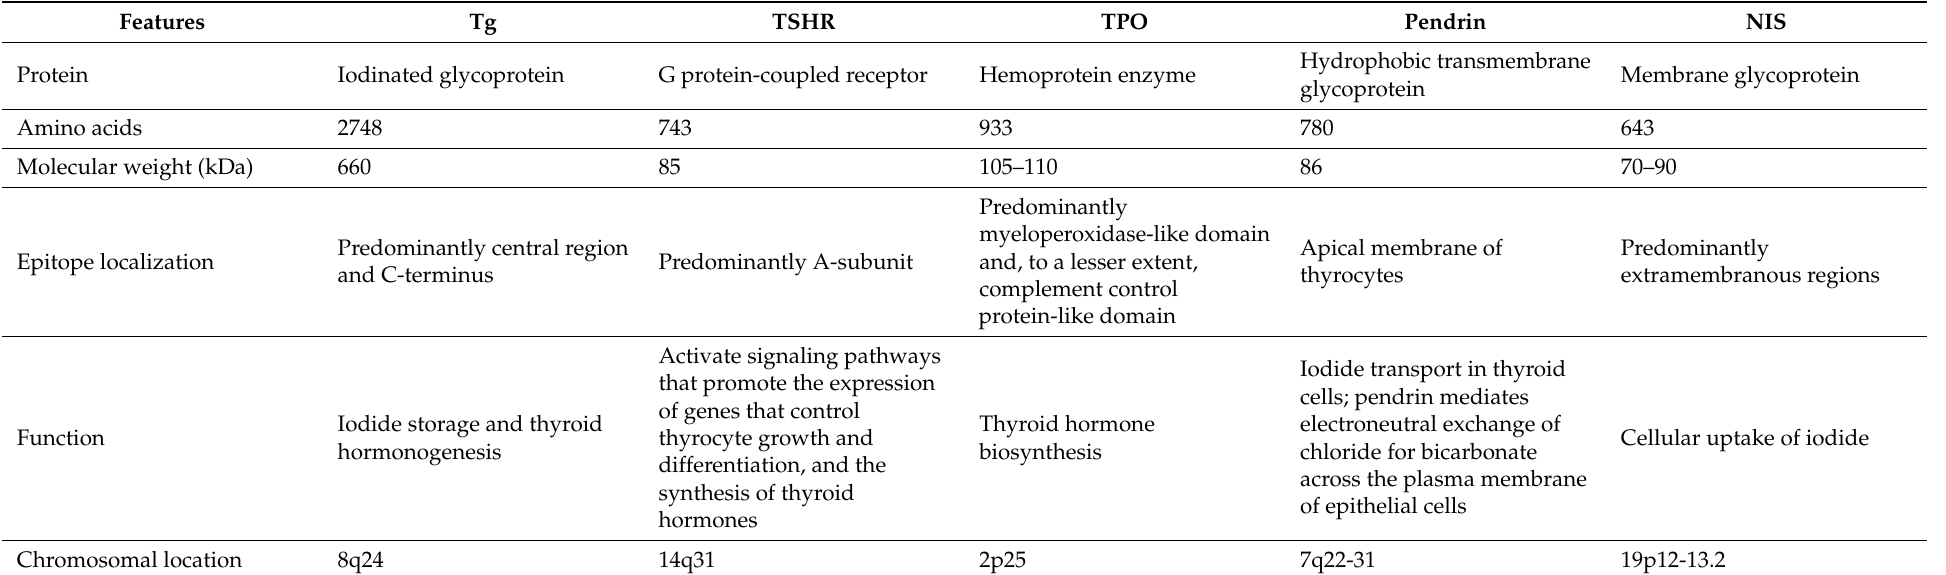
Table 9. Main features of thyroid